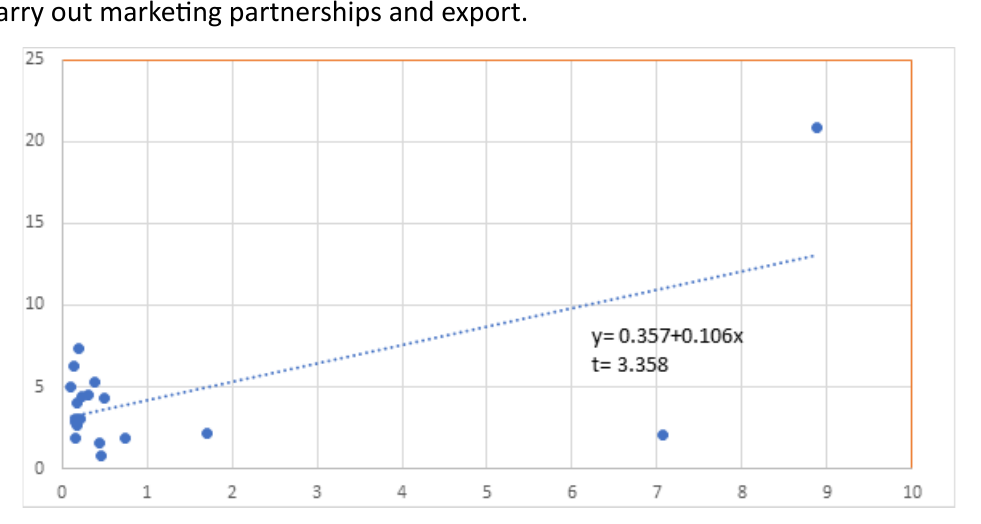
Figure 7: Scatter Plot of Percentage of MSIs doing Export and Percentage of MSIs doing Marketing